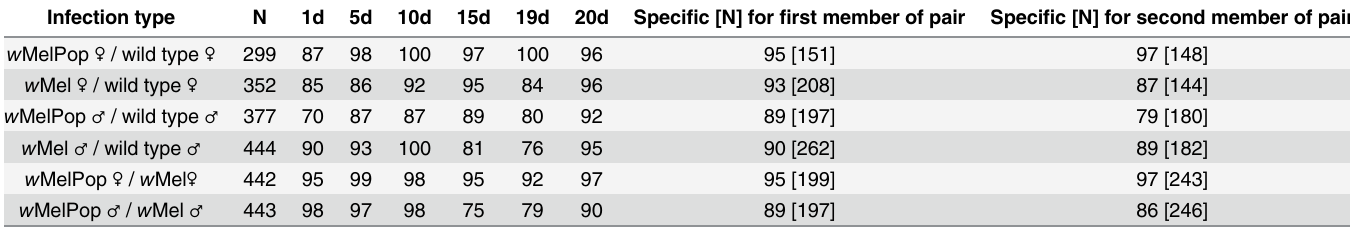
Table 2. Percentage accuracy with which pairs were differentiated at various ages (1 – 20 days), and the specific identification accuracy for the indi- vidual components of those pairs. Infection